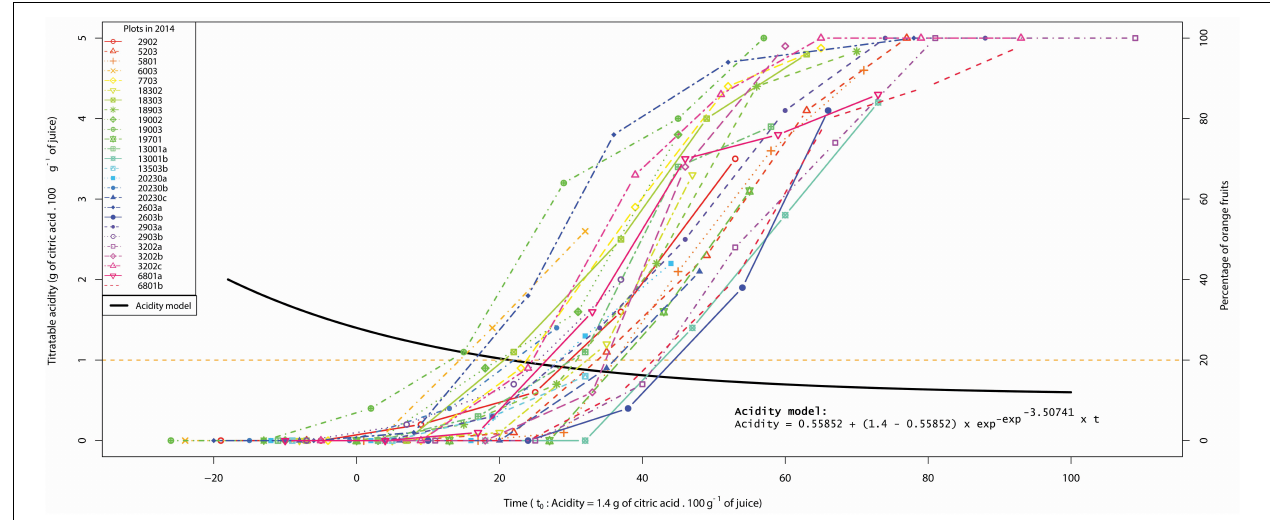
FIGURE 4 | Color dynamics of each plot in 2014 according to the acidity drop model. The left ordinate corresponds to acidity values relative to the model (7) represented by the black curve. The right ordinate corresponds to the percentage of orange fruit relative to the plot coloring dynamics represented by colored curves. Vertical bars in colored curves represent color standard errors. The acidity drop model as well as the color curves fit in the same time frame t 0 = acidity 1.4. The orange horizontal line indicates the 20% orange threshold. TABLE 2 | Relations between morpho-physiological characteristics of orchards and fruit ripening for 2013 and 2014. (cid:72) (cid:72) Y (cid:72) (cid:72) Date acidity 1.4 Date 20% X